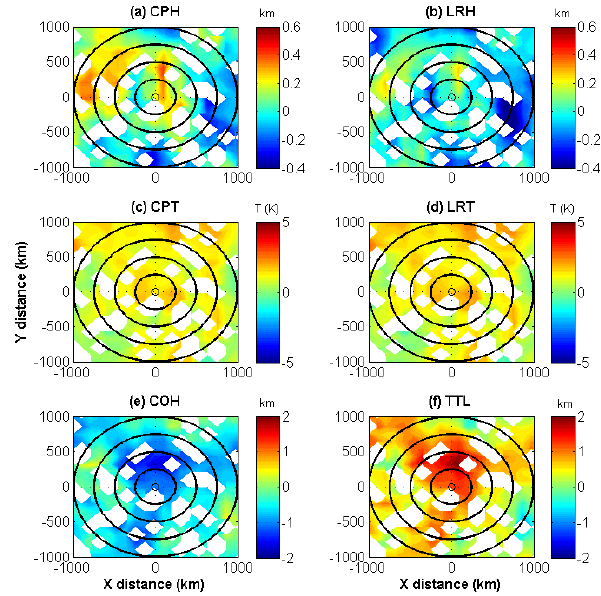
Figure 5. Same as Fig. 4, but for the mean difference in the tropopause parameters between climatological mean and individual tropopause parameters observed during TCs (irrespective of cyclone